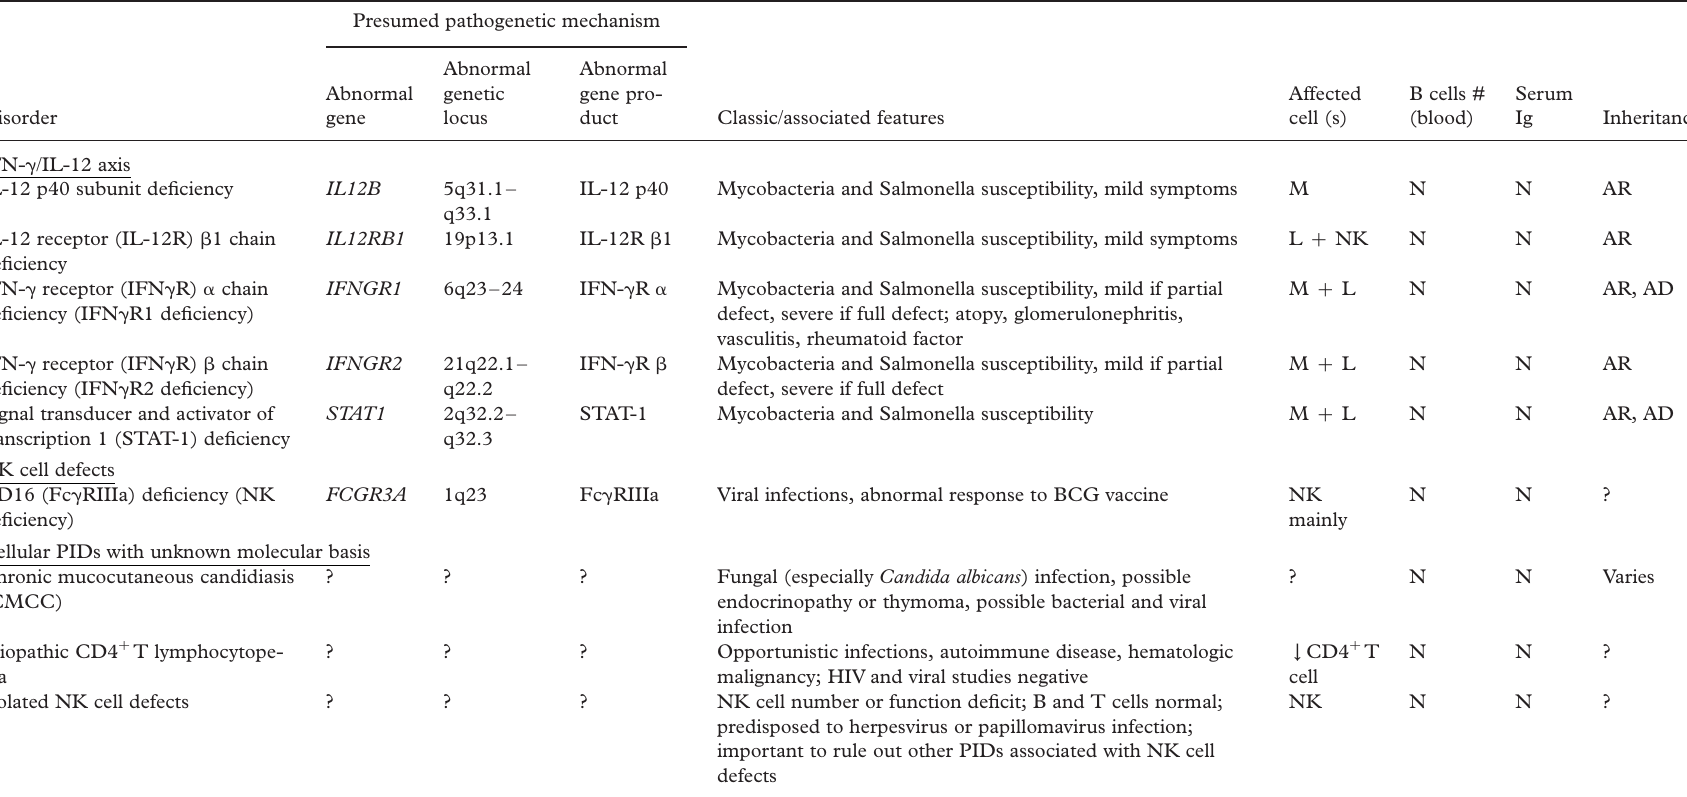
Table II. Cellular